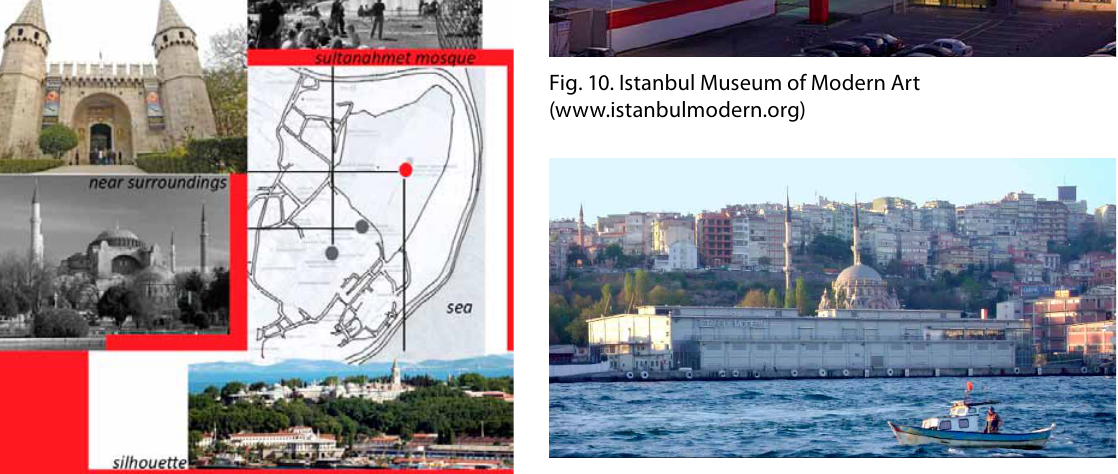
fig. 11. Istanbul Museum of Modern